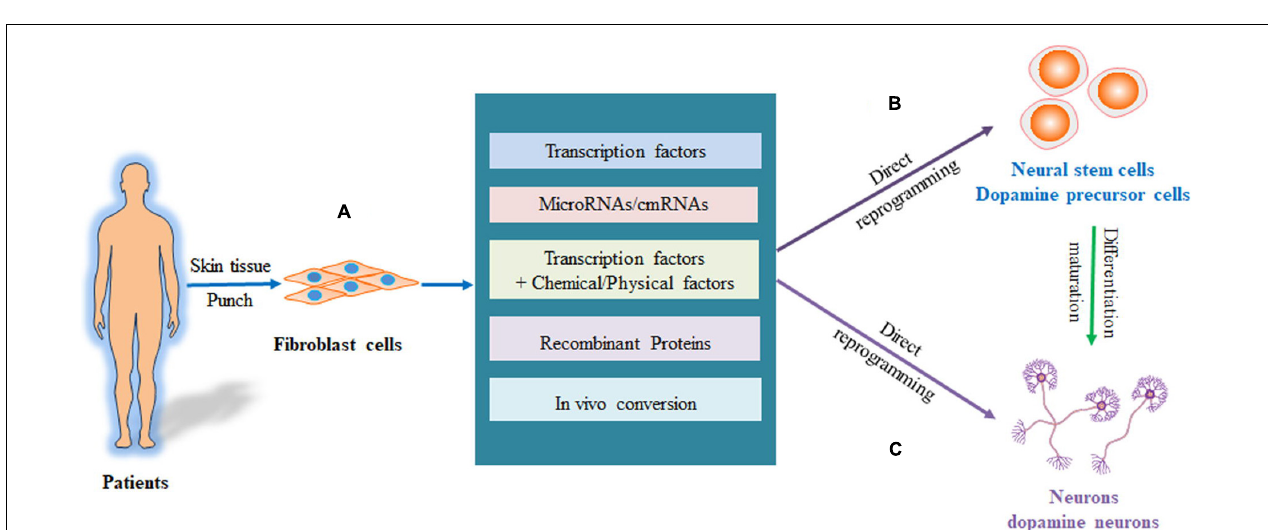
FIGURE 2 | Process of directly reprogramming fibroblasts into neurons and DA neurons. (A) The fibroblasts are isolated from patients and reprogrammed to iPS cells, which are then differentiated into neurons or DA neurons. (B) The fibroblasts are directly converted to neural stem cells or dopaminergic precursor cells, which are then induced into neurons or DA neurons. (C) The fibroblasts can be directly reprogrammed into neurons or DA neurons. DA, dopaminergic neurons; iPS cells, pluripotent stem